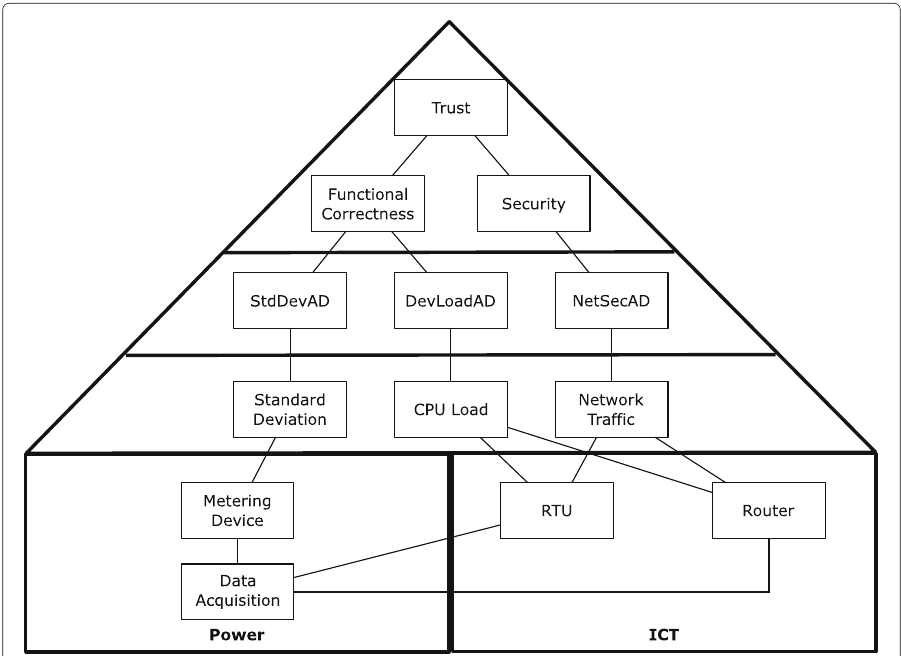
Fig. 2 An instantiation of the trust assessment pyramid for the proof of